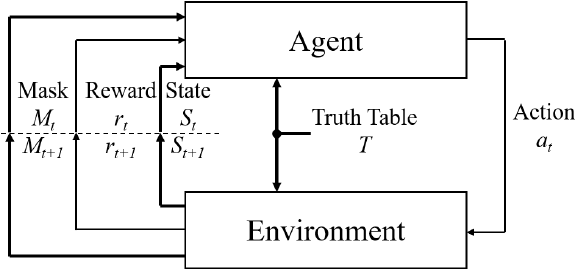
Figure 1. Proposed GateRL block